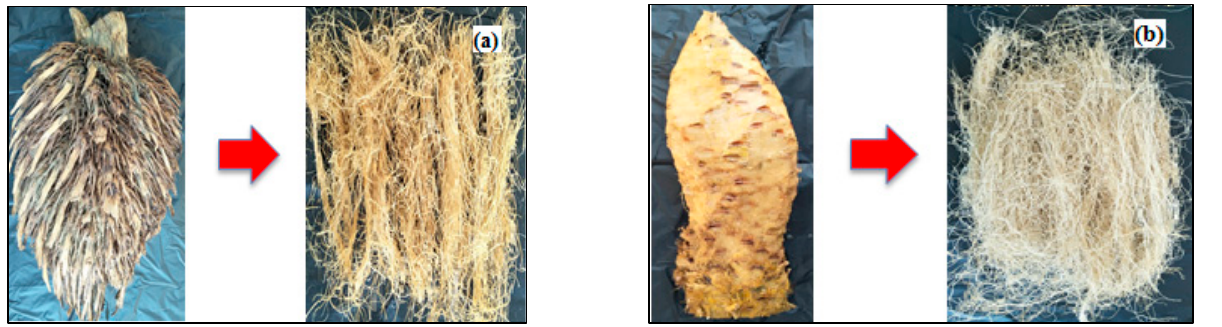
Figure 2. ( a ). WEFB is converted into fibers with a length of 10–20 cm before the cutting process with a cutting machine; ( b ). SEFB is converted into fibers with a length of 10–30 cm before the cutting process with a cutting machine.